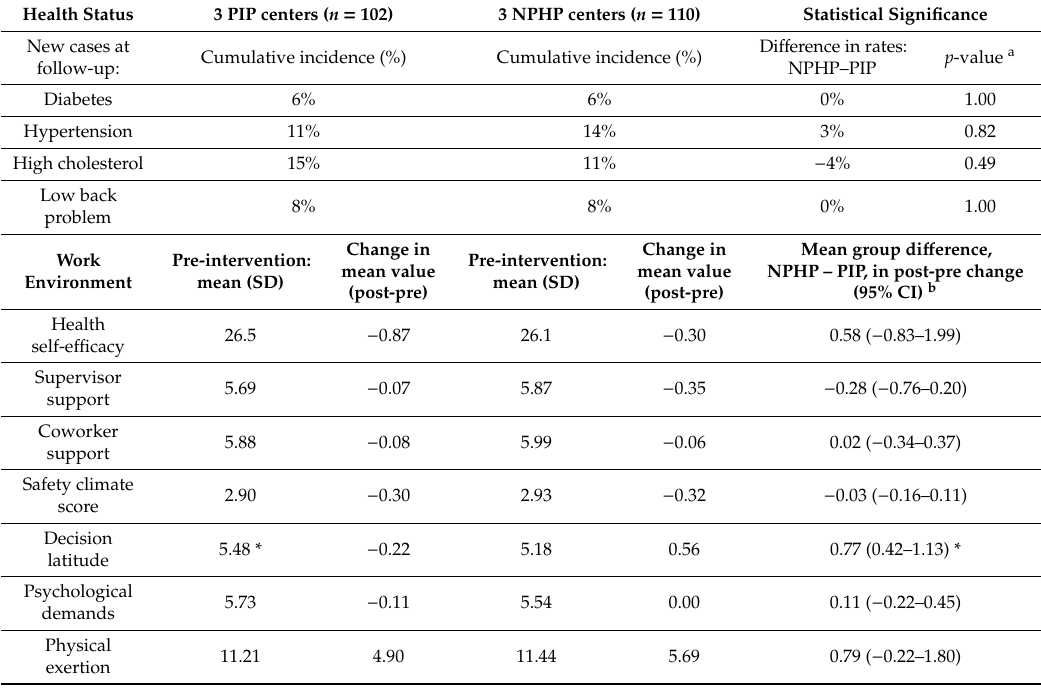
Table 2. Worker health and working conditions in pre- and post-intervention matched pair surveys: Comparison of PIP and NPHP